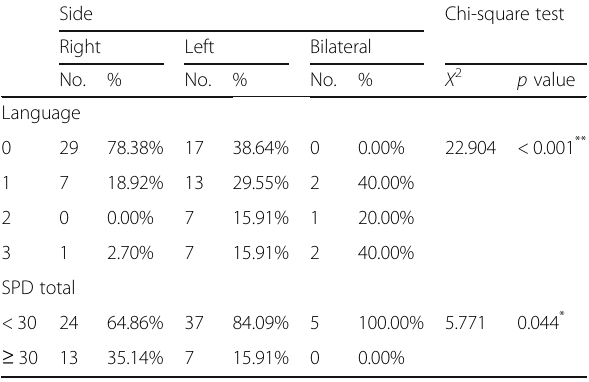
Table 9 Correlation between NIHSS and SPD-CAT language subscale scores with hemispheric lesion side of stroke Side Chi-square test Right Left